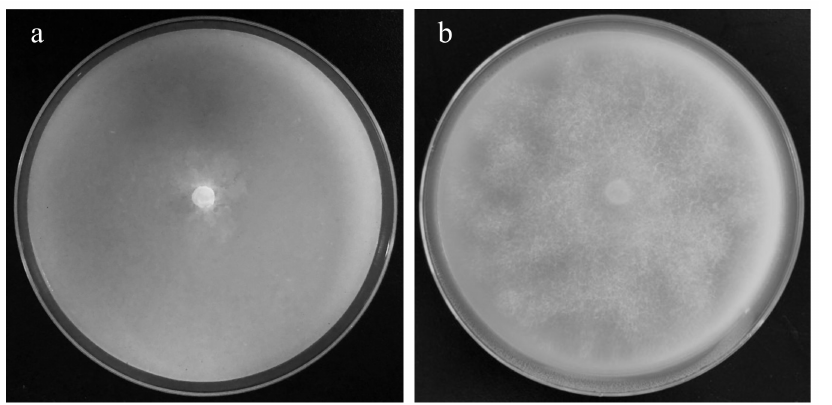
Figure 1. Fumigation effect of PBB on Phytophthora nicotianae . ( a ), 4 g/dish of PBB; ( b ), control.